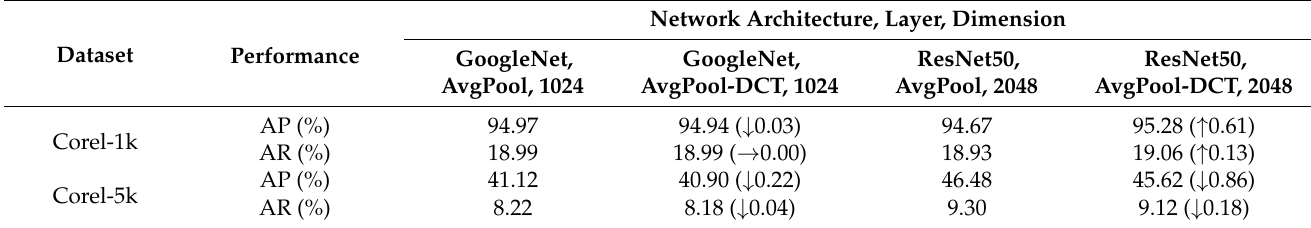
Table 6. APs and ARs results by applying DCT to deep features, Top NR = 20.